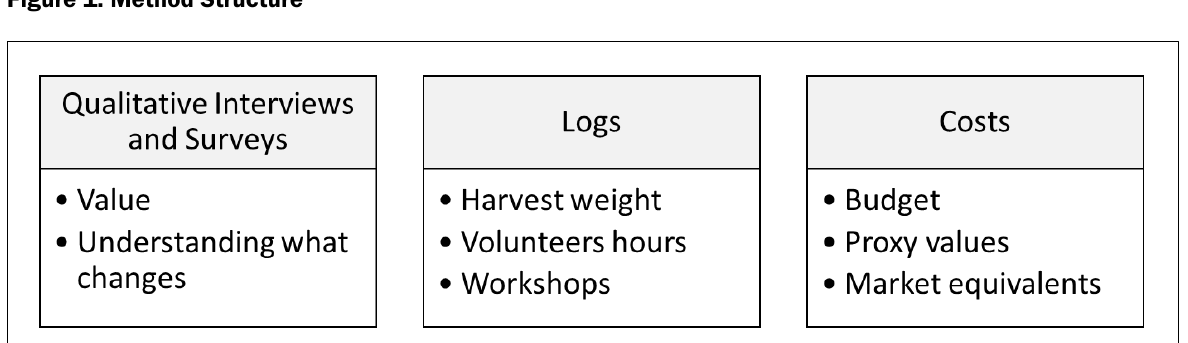
Figure 1. Method